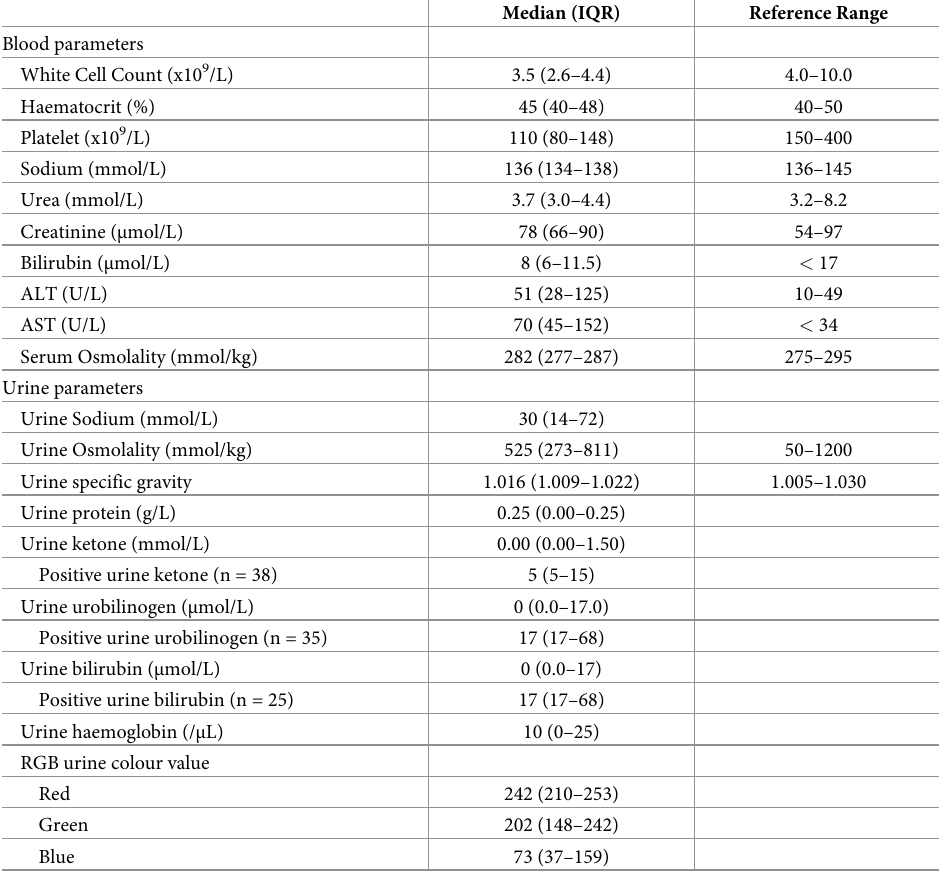
Table 2. Laboratory investigation and urine RGB colorimetry code